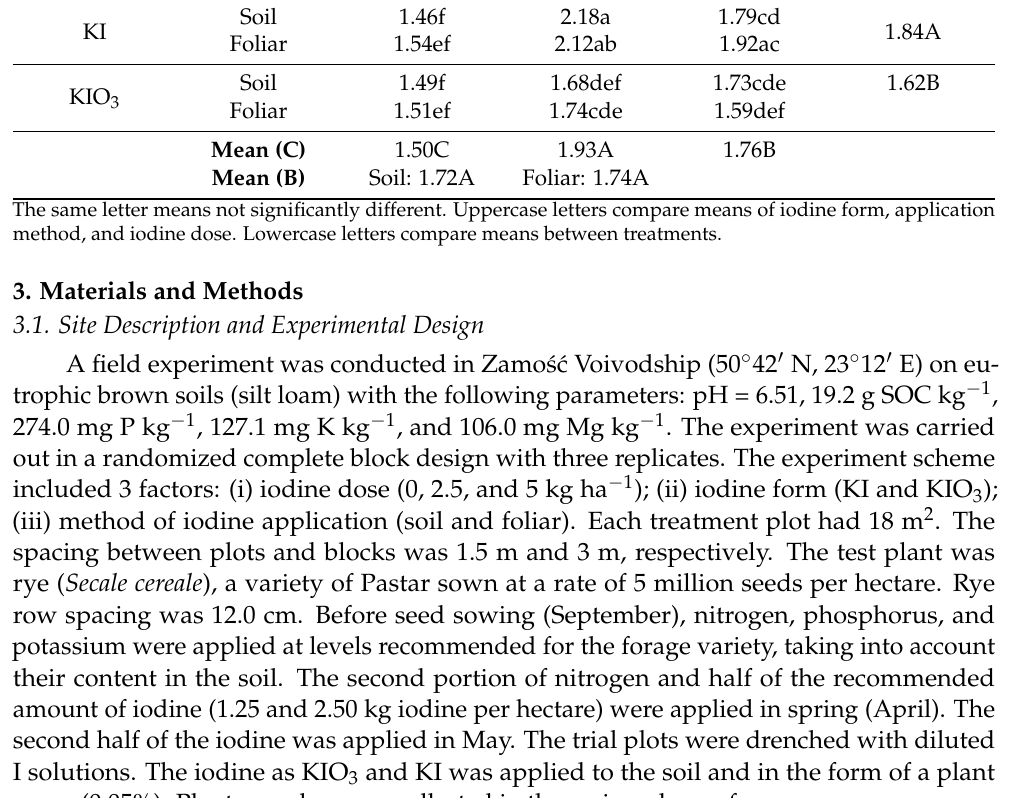
Table 8. Content of protein in rye plants depending on I dose, form, and method of application. Iodine Dose Application Iodine Form (C) Mean Method (A) (B) 0 2.5 5 (mg g − 1 Fresh Weight) Soil KI